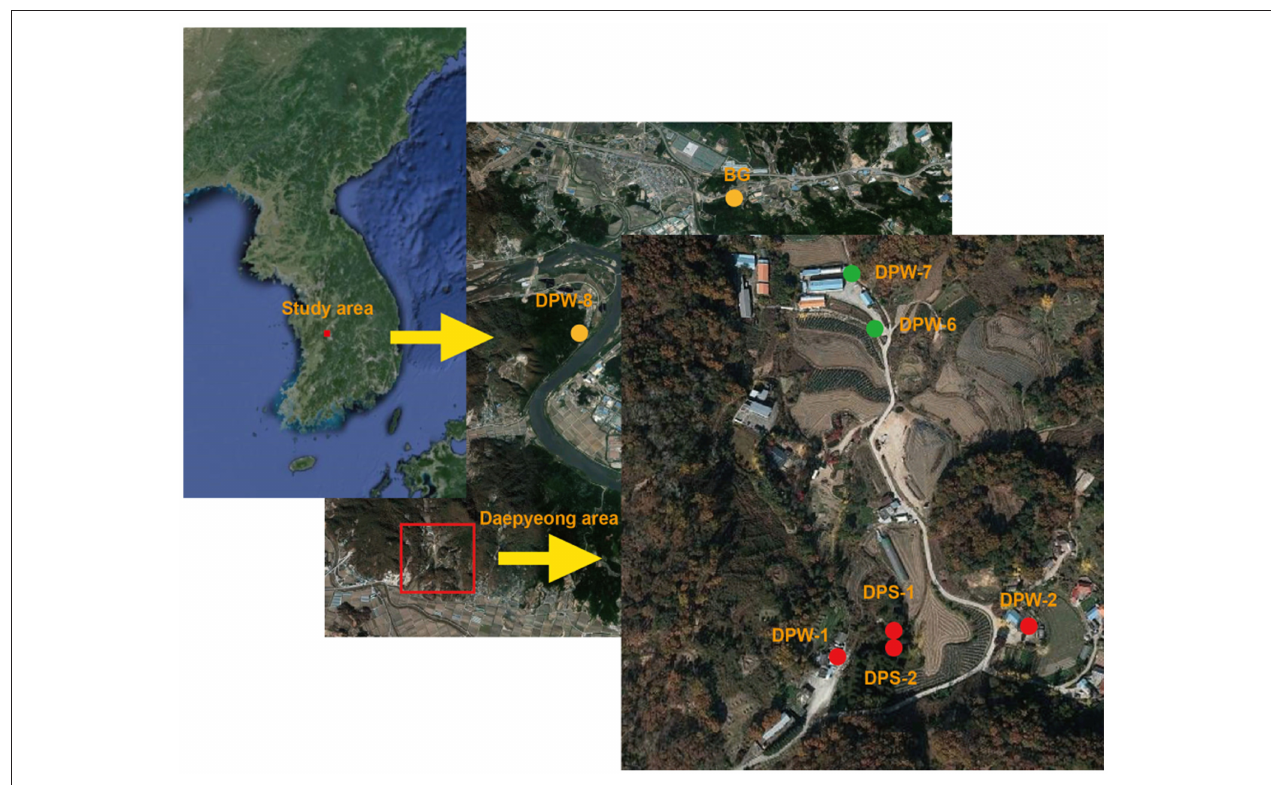
FIGURE 1 | Location map for study area and sampling points in South